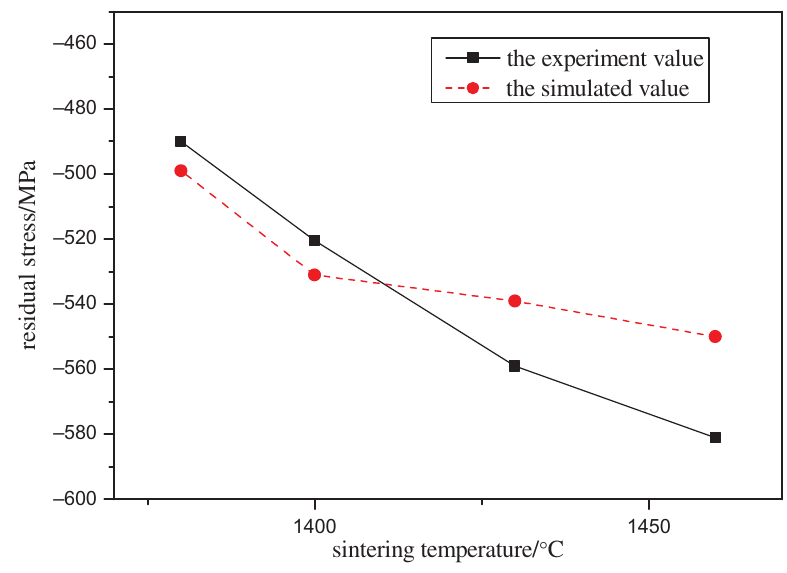
Figure 9: The maximum compression stress of FGCC-T5 by different sintering